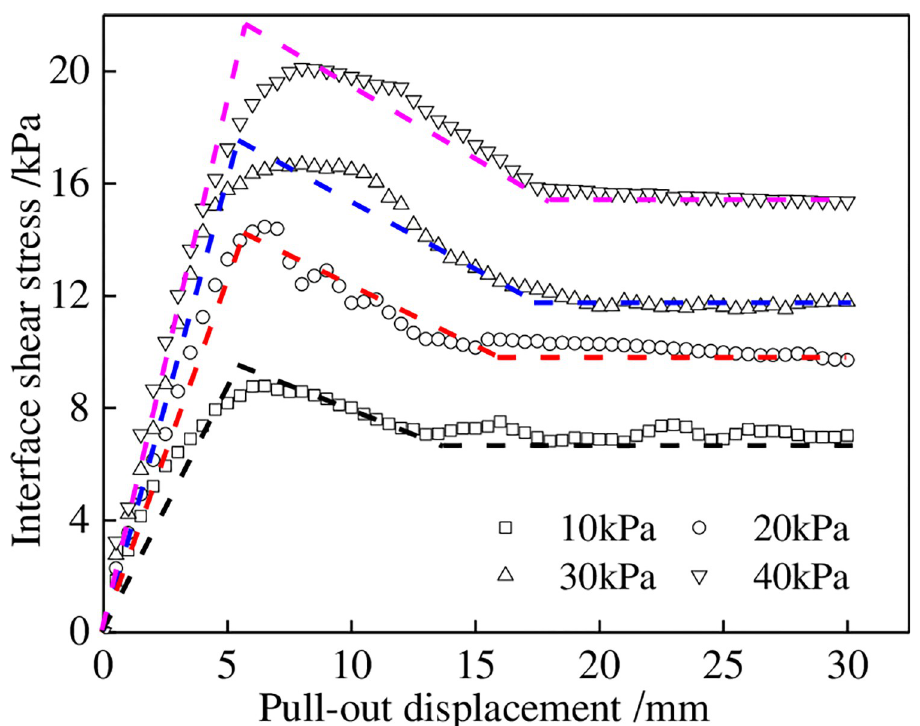
Fig 15. Comparison between the pull-out test results and model predicted results for